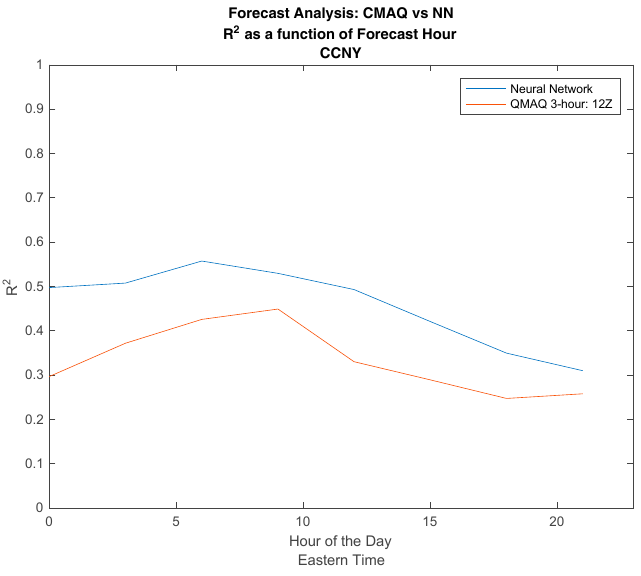
Figure 6. Comparing the effect of different release times for the NN in comparison to CMAQ by plotting the R 2 value as a function of time of day.